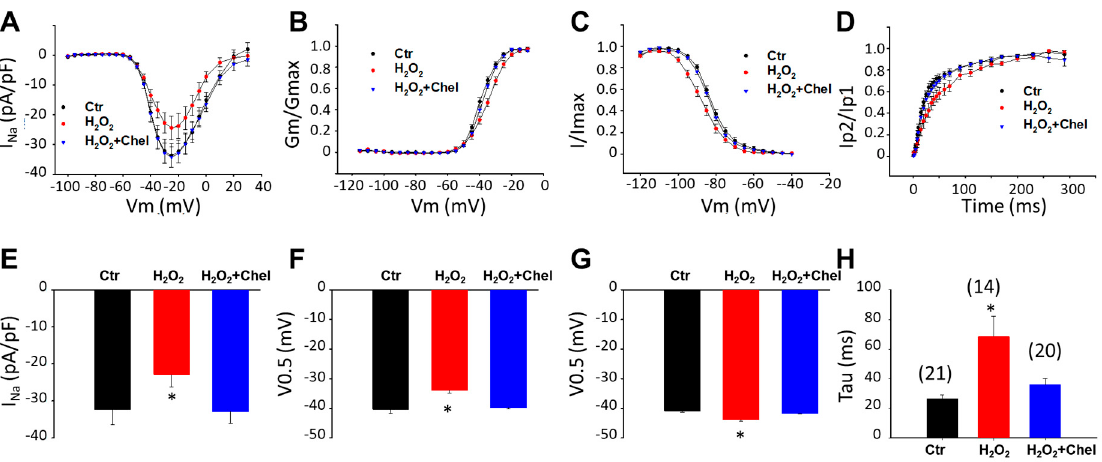
Figure 12. A PKC inhibitor abolished the effects of H 2 O 2 on sodium channels in hiPSC-CMs from the BrS-patient. Cells were treated with vehicle (water and DMSO, Ctr) or H 2 O 2 (200 μ M) or H 2 O 2 plus 5 μ M chelerythrine, a PKC inhibitor (H 2 O 2 + Chel) for 2 h. ( A ) I–V curves of peak sodium channel currents (I Na ) recorded in SCN10A-hiPSC-CMs. ( B ) Activation curves of peak I Na recorded in SCN10A-hiPSC-CMs. ( C ) Inactivation curves of peak I Na recorded in SCN10A-hiPSC-CMs. ( D ) Recovery curves of peak I Na recorded in SCN10A-hiPSC-CMs. ( E ) Mean values of peak sodium channel currents at − 30 mV in SCN10A-hiPSC-CMs. ( F ) Mean values of V0.5 of activation in SCN10A-hiPSC-CMs. ( G ) Mean values of V0.5 of inactivation in SCN10A-hiPSC-CMs. ( H ) Mean values of time constants (Tau) of recovery from inactivation in SCN10A-hiPSC-CMs. Numbers given in H represent the number of cells of measurements for ( A – H ). * p < 0.05 versus Ctr according to one-way ANOVA with Holm–Sidak post-test.